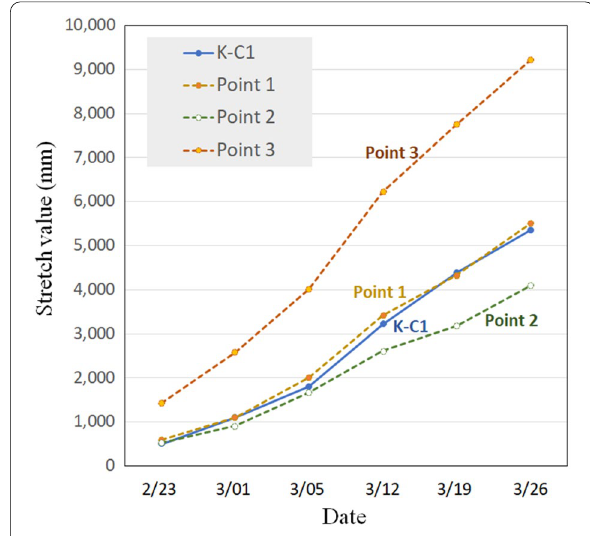
Fig. 14 Monitoring results by